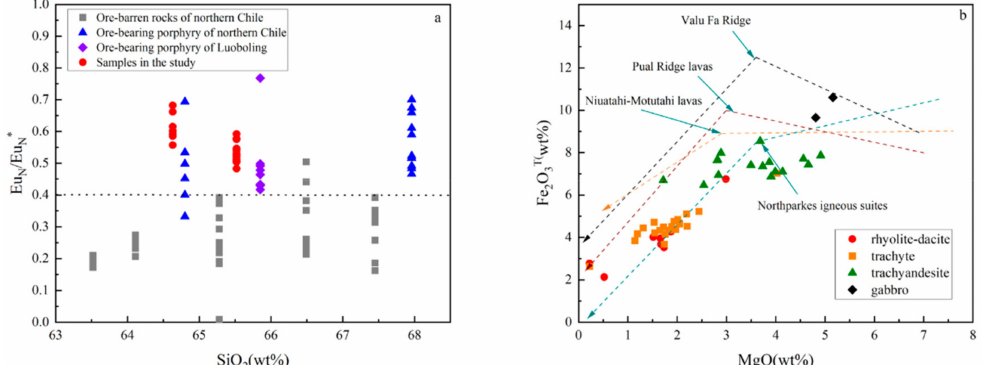
Figure 12. ( a ) Zircon Eu N / Eu N * versus whole rock SiO 2 for volcanic rocks from the Shanghang Basin and other porphyry deposits (data for other deposits are from [4,35,51,89]). ( b ) Whole rock Fe 2 O 3T versus MgO for volcanic rocks from the Shanghang Basin and other arc magmas, data for the latter are from